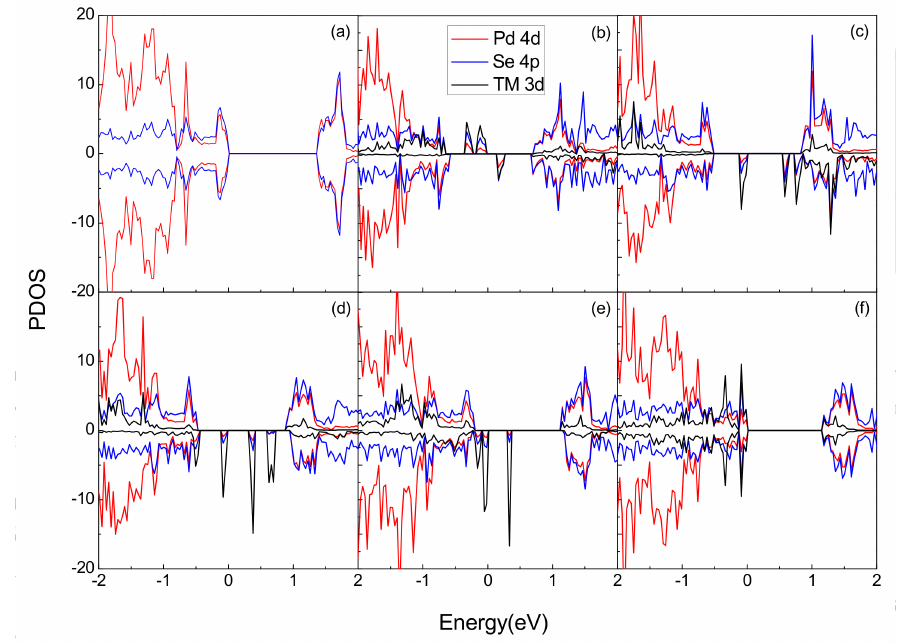
Figure 4. Projected density of states (PDOS) of the different doped systems, ( a ) pristine system, ( b ) Cr-doped system, ( c ) Mn-doped system, ( d ) Fe-doped system, ( e ) Co-doped system, ( f ) Ni-doped system, respectively.